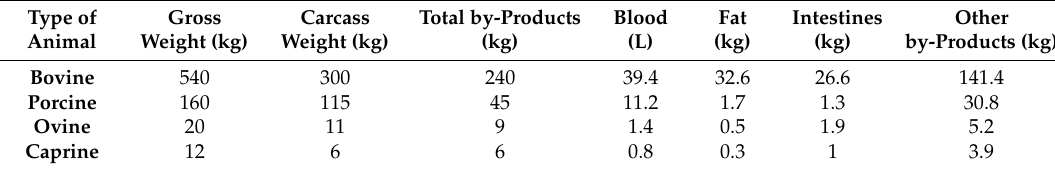
Table 5. Estimate of the quantity of offal generated per carcass [25].